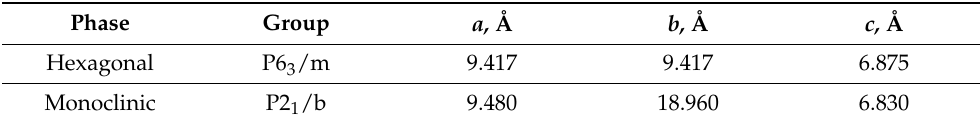
Table 1. Unit cell parameters a,b,c [Å] (from